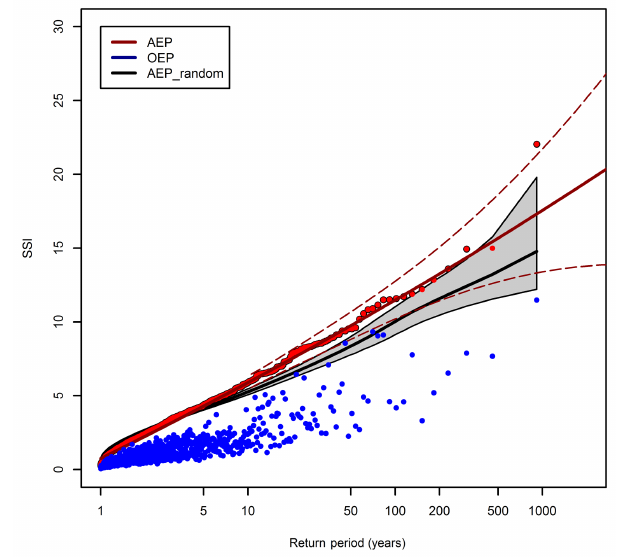
Figure 6. Return periods of the AEP (red points) and OEP (blue points) for HiGEM_bc. The OEP and AEP are sorted according to AEP magnitude. The solid red line is the GPD fit applied to the AEP using a 90th percentile threshold. The dashed red lines are the asso- ciated 95% confidence intervals. The black line represents the mean of 10000 non-replacement random samples of the HiGEM_bc AEP data. The surrounding shaded grey region represents the 95% confi- dence interval of these 10000 samples. The GPD fit and confidence intervals are only plotted above the GPD